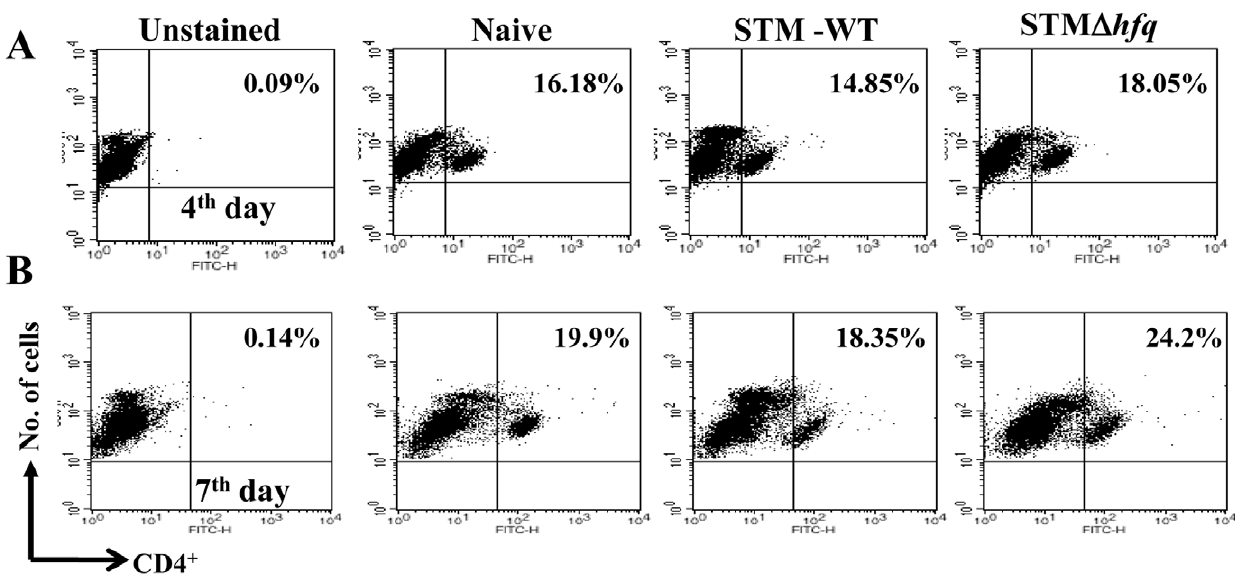
Figure 5. Flow cytometric analysis of CD4 + T cell population in the spleen on 4 th day (A) and 7 th day (B) post infection. Group of mice were inoculated with the STM-WT or STM D hfq with dose of 10 7 bacteria per mouse. Uninfected mice were used as control. Splenocytes were isolated on 4 th and 7 th day post infection from both infected and control mice and stained with FITC-conjugated anti-CD4 MAb. The relative levels of CD4 + T- lymphocytes were measured through FACS. Data was analyzed with BD Cell-Quest software and represented by dot plot. The results are representative of two independent experiments. Each group consisted of 4-5 mice. Statistical significance was defined as follows: (* p , 0.05) (Student’s t test).